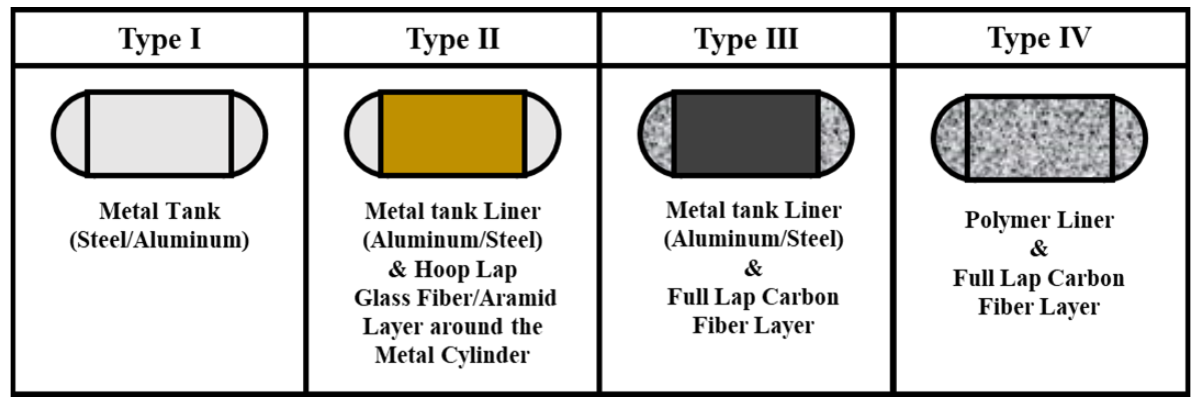
Figure 5. Compressed Hydrogen, Storage Tanks.